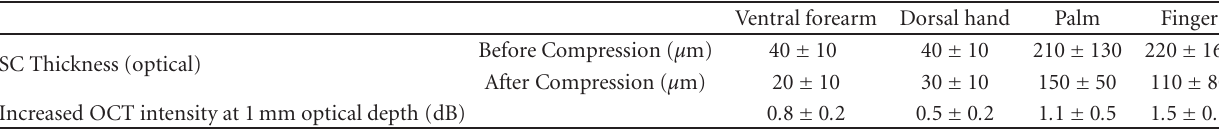
Table 2: In vivo human skin measurements. Ventral forearm Dorsal hand